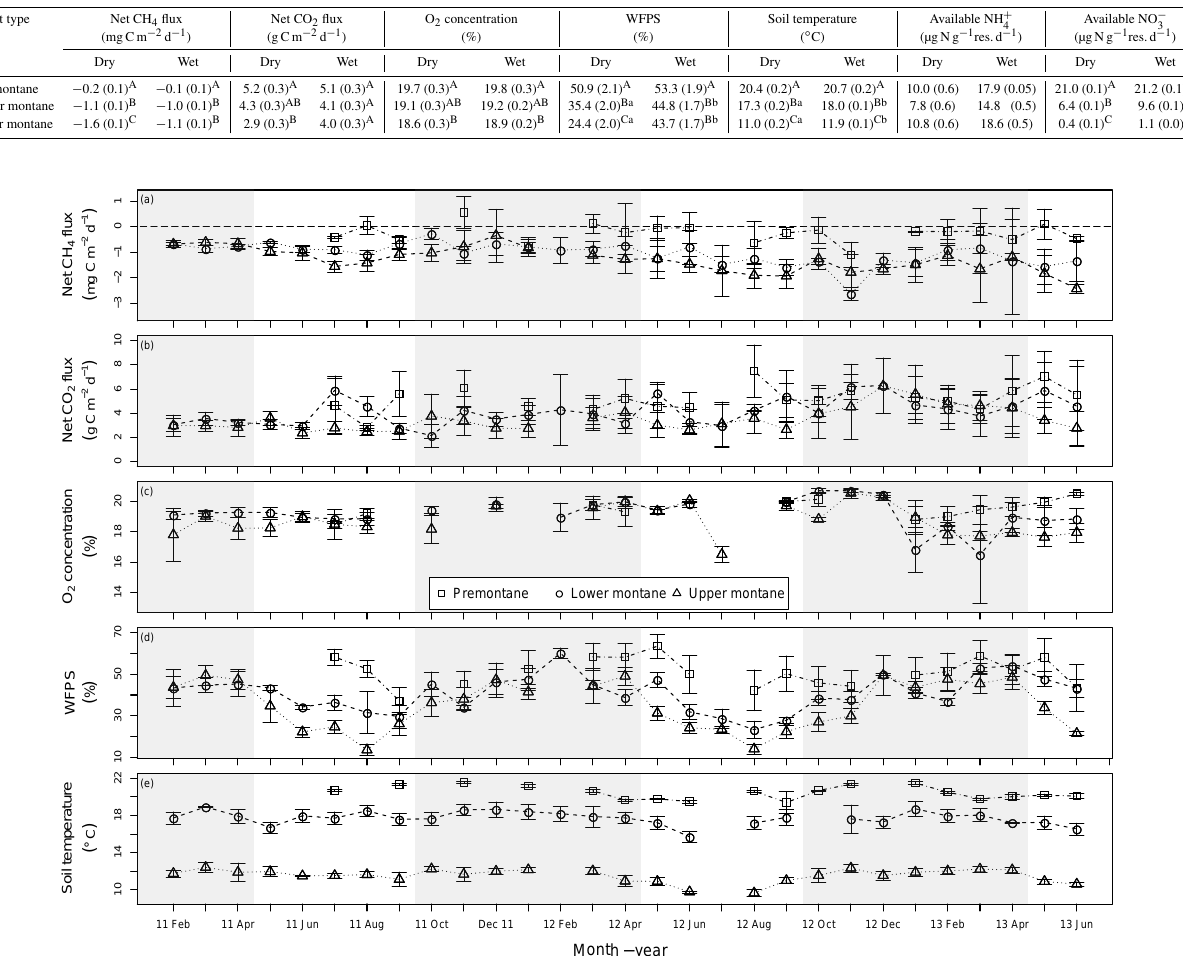
Figure 2. Monthly forest type means and standard deviation of (a) net CH 4 flux, (b) net CO 2 flux, (c) soil O 2 concentration, (d) WFPS and (e) soil temperature. Shading indicates the wet season of